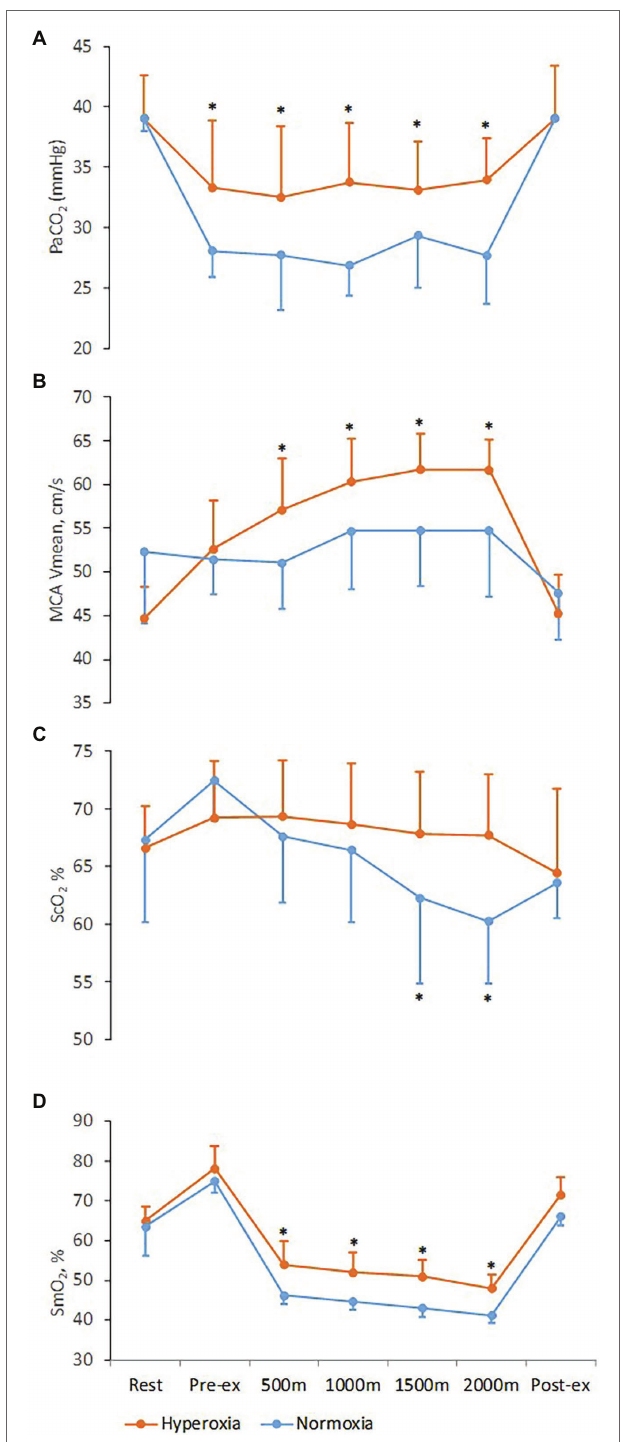
FIGURE 3 | Respiratory, cerebrovascular, and muscle variables at rest and during 2,000 m all-out ergometer rowing with normoxia and hyperoxia. Pre-ex and post-ex values are obtained after the warm-up and 15 min into the recovery, respectively. (A) PaCO 2 , arterial carbon dioxide tension; (B) MCA V mean , middle cerebral artery mean blood flow velocity; (C) ScO 2 , frontal lobe oxygen saturation; (D) SmO 2 , oxygenation of the vastus lateralis muscle. Values are means ± SD; * Difference between normoxic and hyperoxic trials ( N = 11, p <